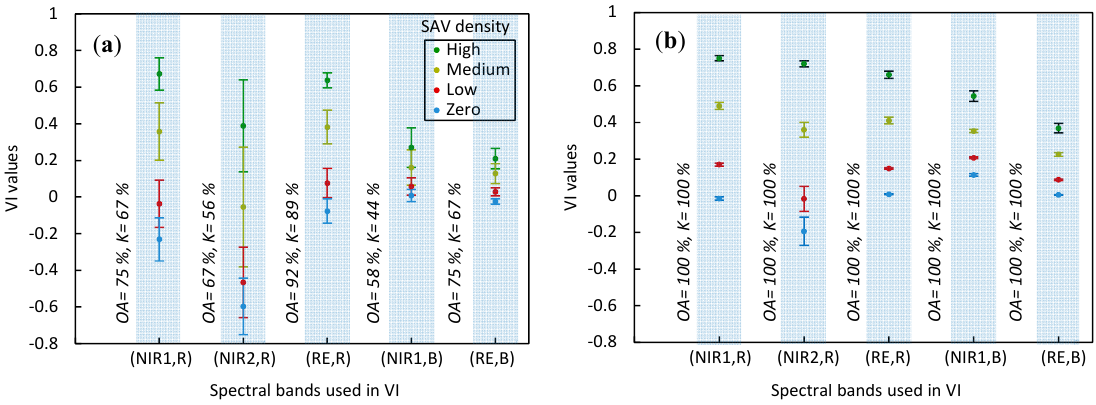
Figure 5. Evaluating the effectiveness of VIs in clustering SAVs with different densities in laboratory experiments. k-means clustering is applied on VIs with different band combinations (a) before and (b) after water-column correction. Zero-density SAVs stand for non-vegetated gravel bed. OA: overall accuracy; K: kappa coefficient.